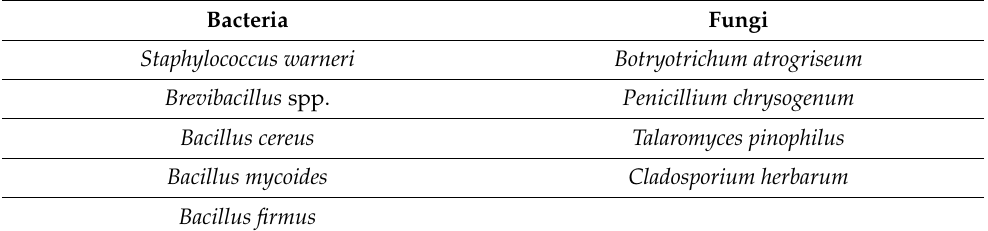
Table 5. Bacterial and fungal species identified in the bio-patina of the